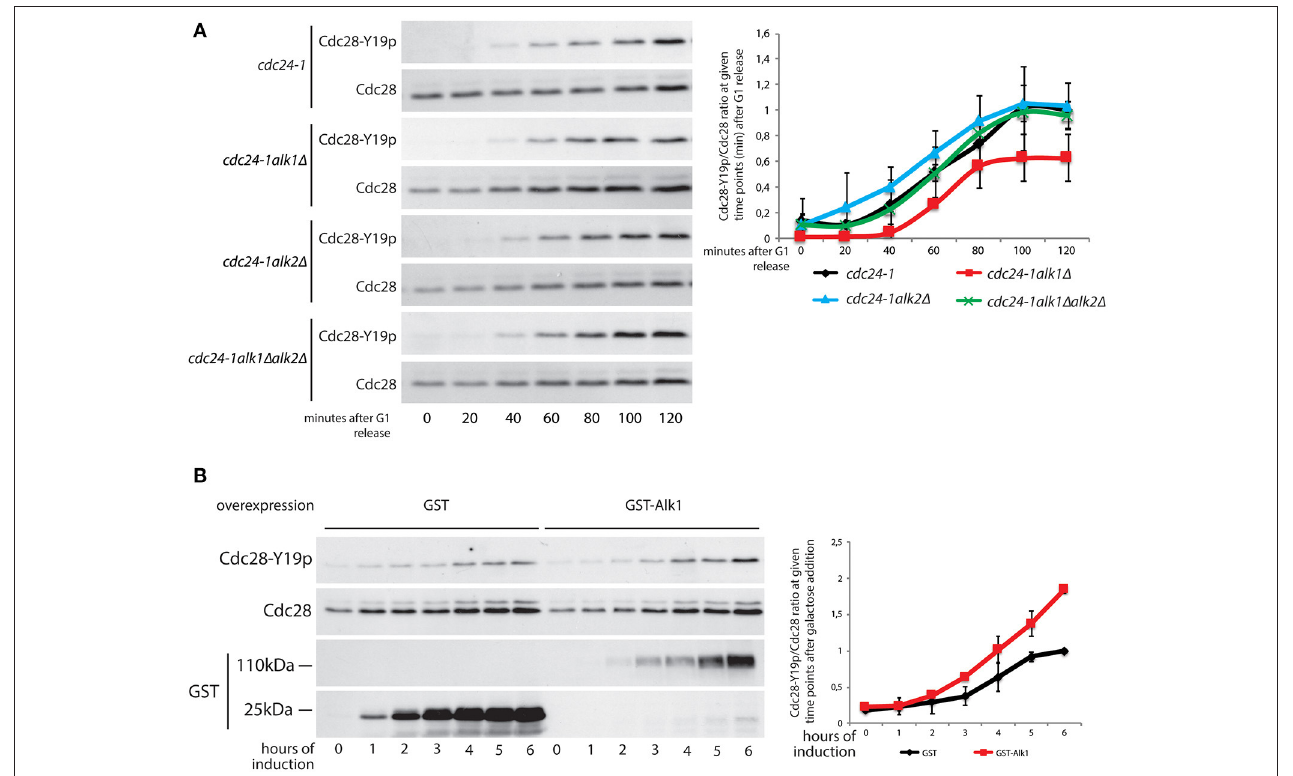
FIGURE 4 | Alk1 is required for sustained Cdc28-Y19 phosphorylation. (A) Cells of the indicated strains were synchronized in G1 at permissive temperature and held at 37 ◦ C for further 45’ before being released into the cell cycle at restrictive temperature. Samples were taken every 20’ to follow protein levels by western blot using antibodies for total Cdc28 and phosphospecific antibodies for Cdc28-Y19p. The right panel reports the quantification of the phosphorylation signals normalized over the total Cdc28. Error bars represent standard deviation (B) Logarithmically growing cells, bearing the pGAL- GST or pGAL- GST-ALK1 constructs, were incubated in the presence of 2% galactose to induce protein overexpression. Samples were taken every hour to monitor protein levels. Western blotting was performed with antibodies for total Cdc28 and phosphospecific antibodies for Cdc28-Y19p. Expression levels of GST and GST-Alk1 were analyzed with anti GST antibodies. The graph shows the ratio between phosphorylated Cdc28-Y19 and total Cdc28, error bars represent standard